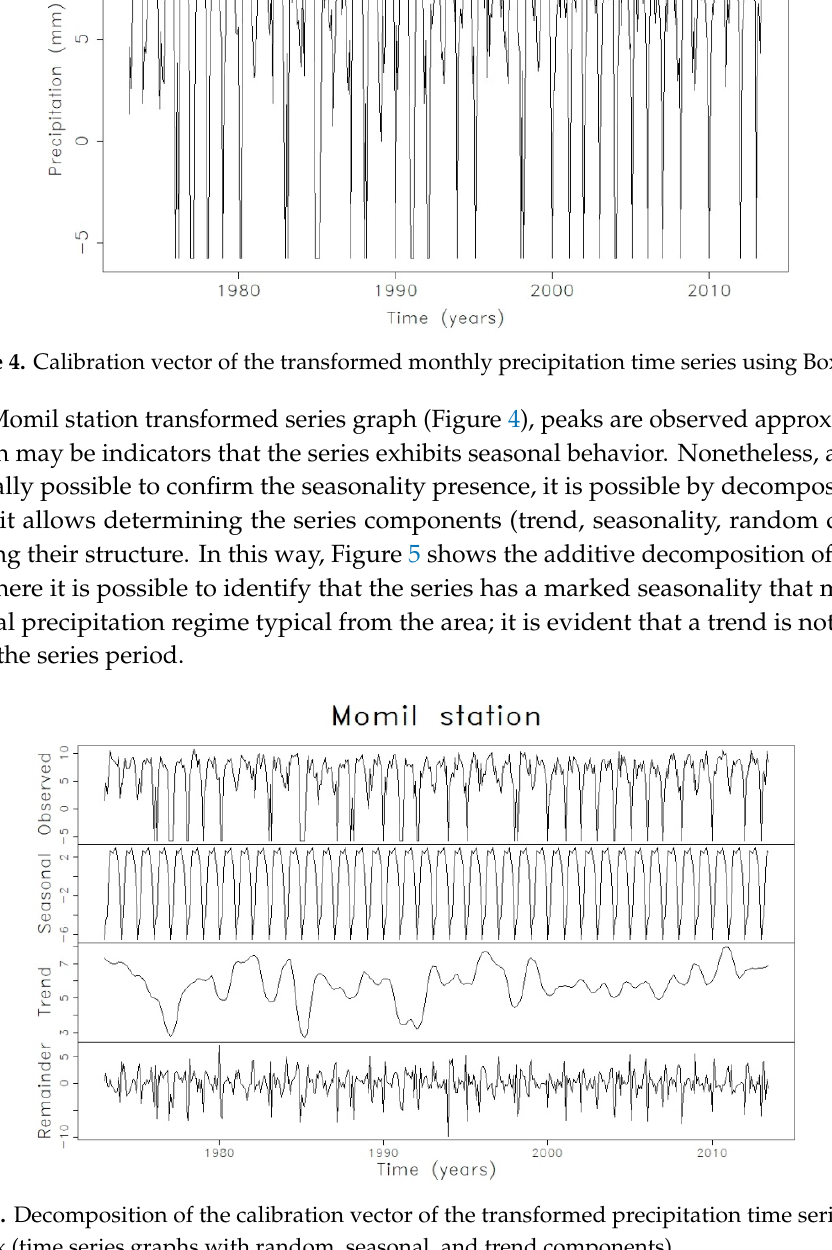
Figure 5. Decomposition of the calibration vector of the transformed precipitation time series using Box–Cox (time series graphs with random, seasonal, and trend components).